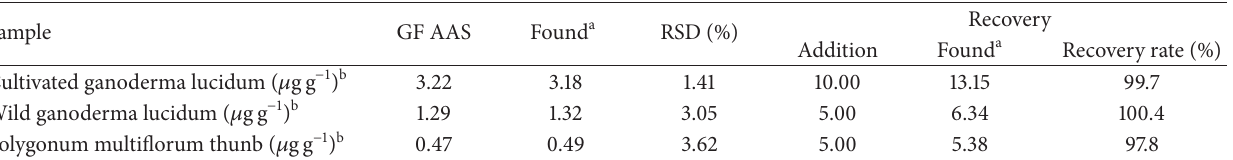
Recovery Addition Found a Recovery rate (%)